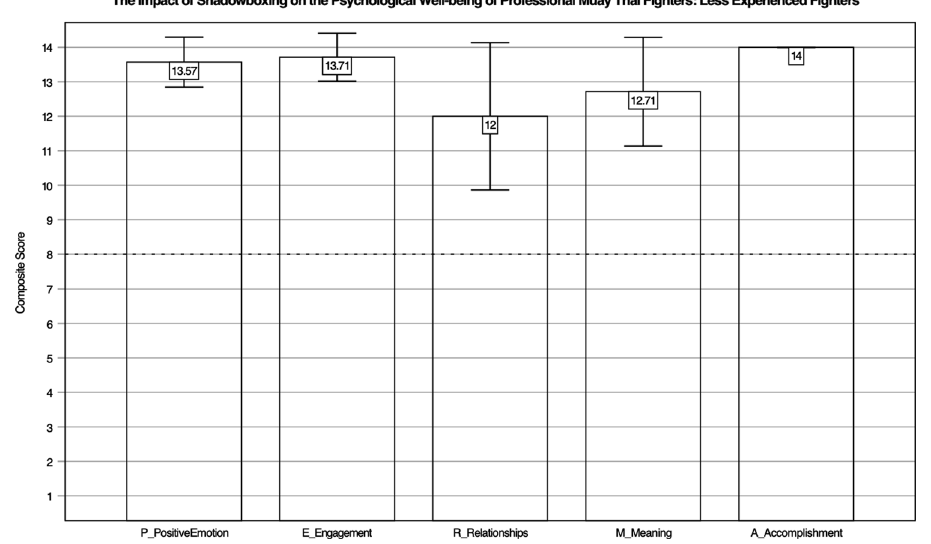
Fig. 5 This figure provides a bar plot with 95% confidence intervals (CIs) for composite PERMA scores: less experienced Nak Muays (n = 7). For each element of psychological well-being, the lowest possible composite score is 2 representing that professional Nak Muays strongly agree that shadowboxing negatively impacts that element of psychological well-being, whereas the highest possible composite score is 14 representing that professional Nak Muays strongly agree that shadowboxing positively impacts that element of psychological well-being. A composite score of 8 (dotted line) reflects a neutral position on whether shadowboxing contributes positively or negatively to that ele- ment. Results in this figure show that less experienced Nak Muays strongly agree that shadowboxing positively contributes to all elements of their psychological well-being. Further, results in this figure show that shadowboxing contributes to the elements of psychological well- being in the following rank-order for less experienced Nak Muays: accomplishment (A), engagement (E), positive emotions (P), meaning (M), and relationships